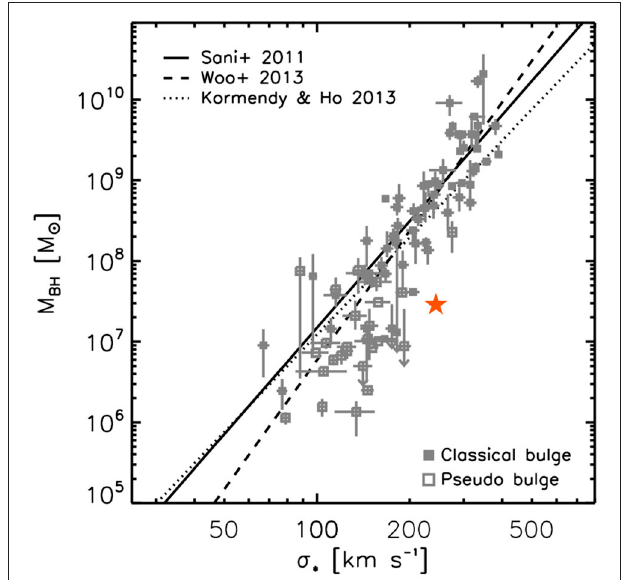
FIGURE 1 | The M BH - σ ⋆ plane for a local sample of BHs with dynamically measured M BH from Sani et al. (2011) and Kormendy and Ho (2013), scaling relations computed in this two works are also shown. Since our M BH are based on a virial factor f = 4.31, we also shown the scaling relation by Woo et al. (2013) that adopts the same f factor. The position of NGC 1275 is marked with an orange star. Classical and pseudo-bulges are marked with filled and open squares,